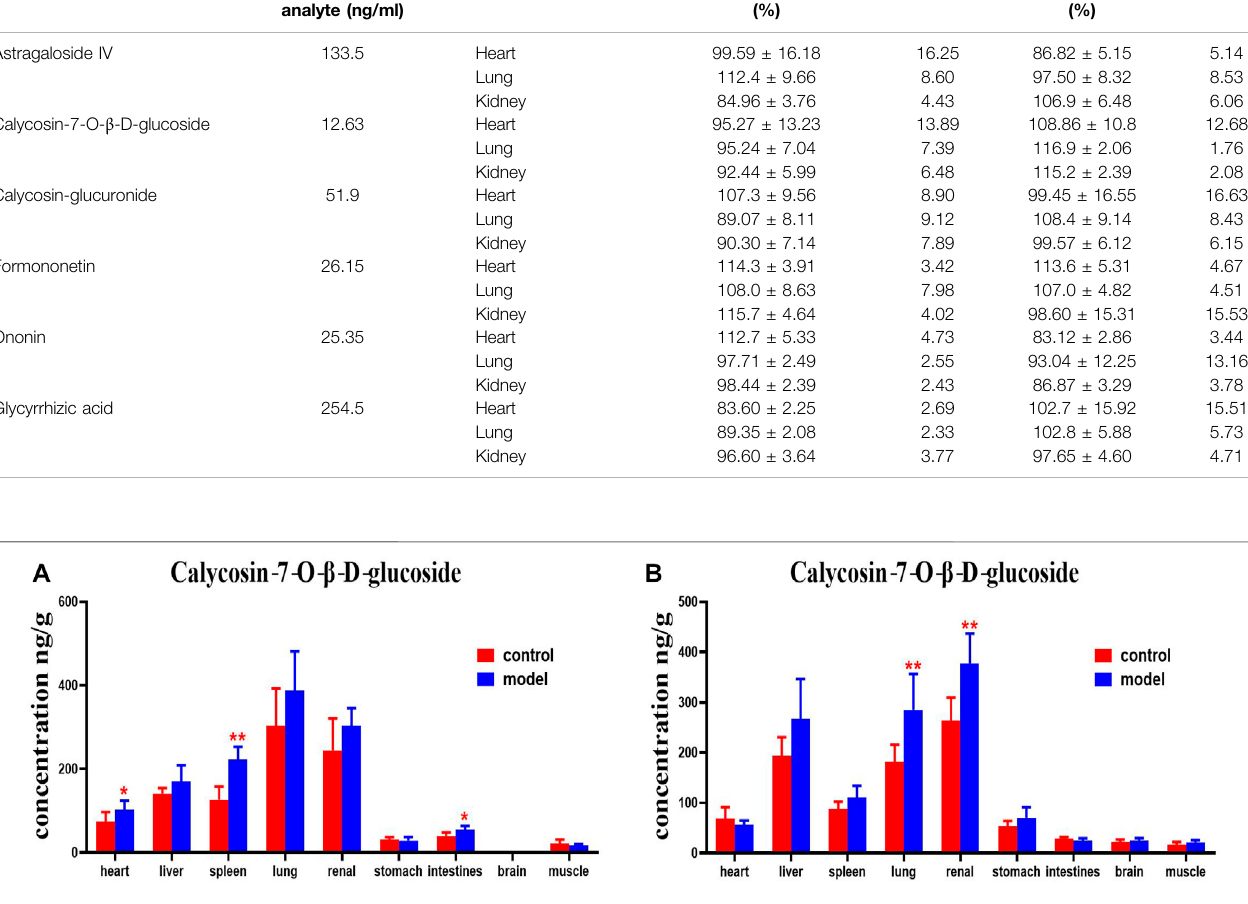
TABLE 4 | The mean recoveries of ingredients in tissue homogenate samples (x ± SD; n = 6). Analyte